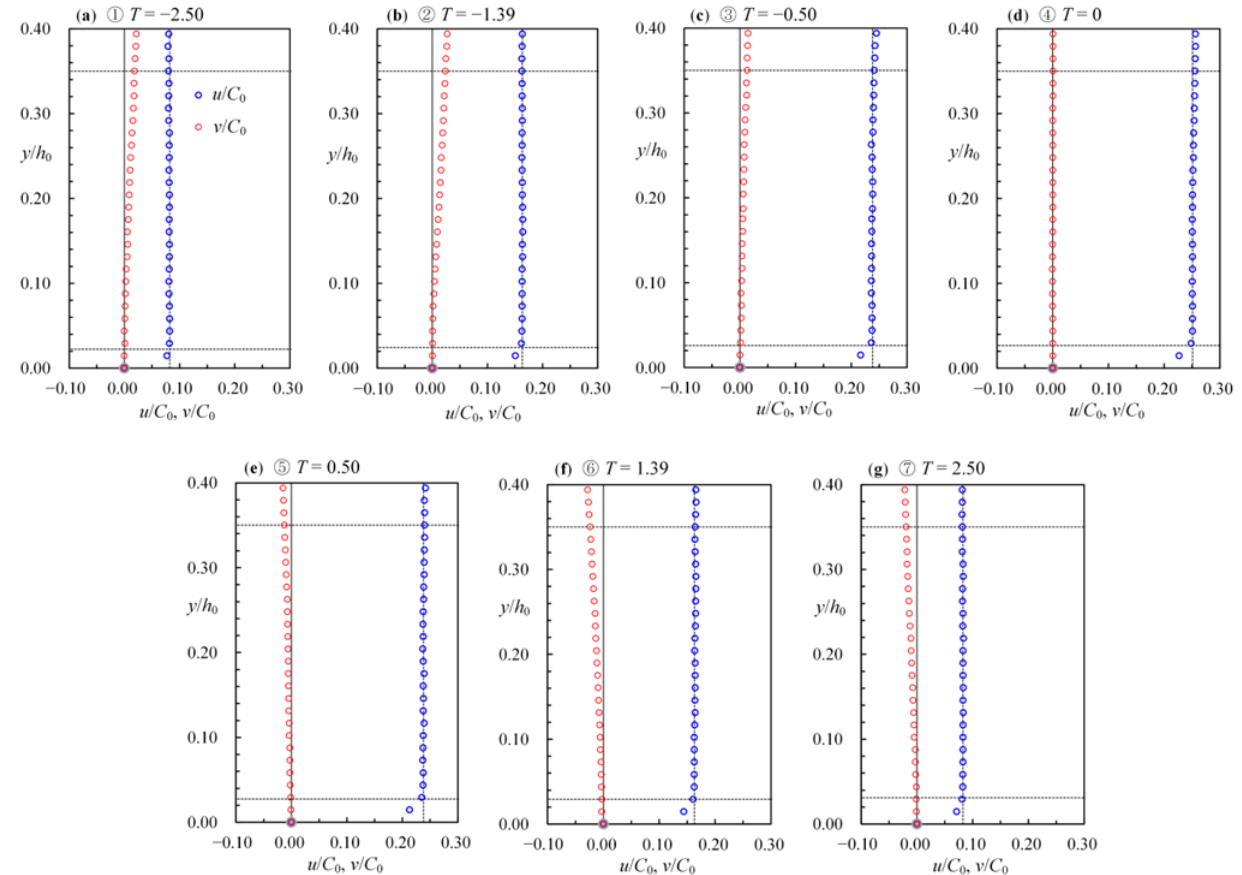
Figure 8. Temporal variation of the horizontal velocity profile obtained in the boundary layer and the FSZ at T = ( a ) −2.50; ( b ) − 1.39; ( c ) −0.50; ( d ) 0; ( e ) 0.50; ( f ) 1.39; and ( g ) 2.50 (Case E). Note that the FSZ is located within the region as marked by the two horizontal dashed lines, and that the internal zone or boundary layer is situated beyond the upper or beneath the lower horizontal dashed line.